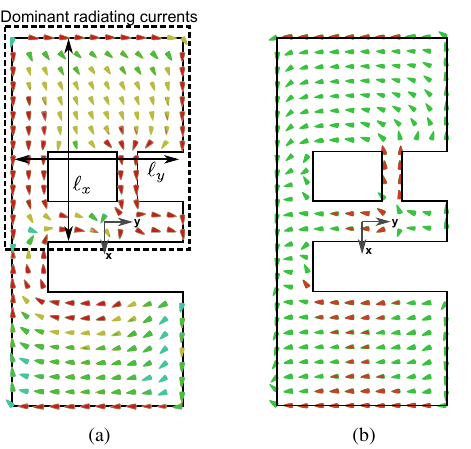
FIGURE 9. Vector plots of the electric surface currents J s for a typical CP E-shaped patch using the shorted bar approach. (a) ωt = Ω 0 , showing a mode that primarily radiates an x -directed electric field. (b) ωt = Ω 0 + π/ 2 , showing a mode radiating y -directed electric fields.